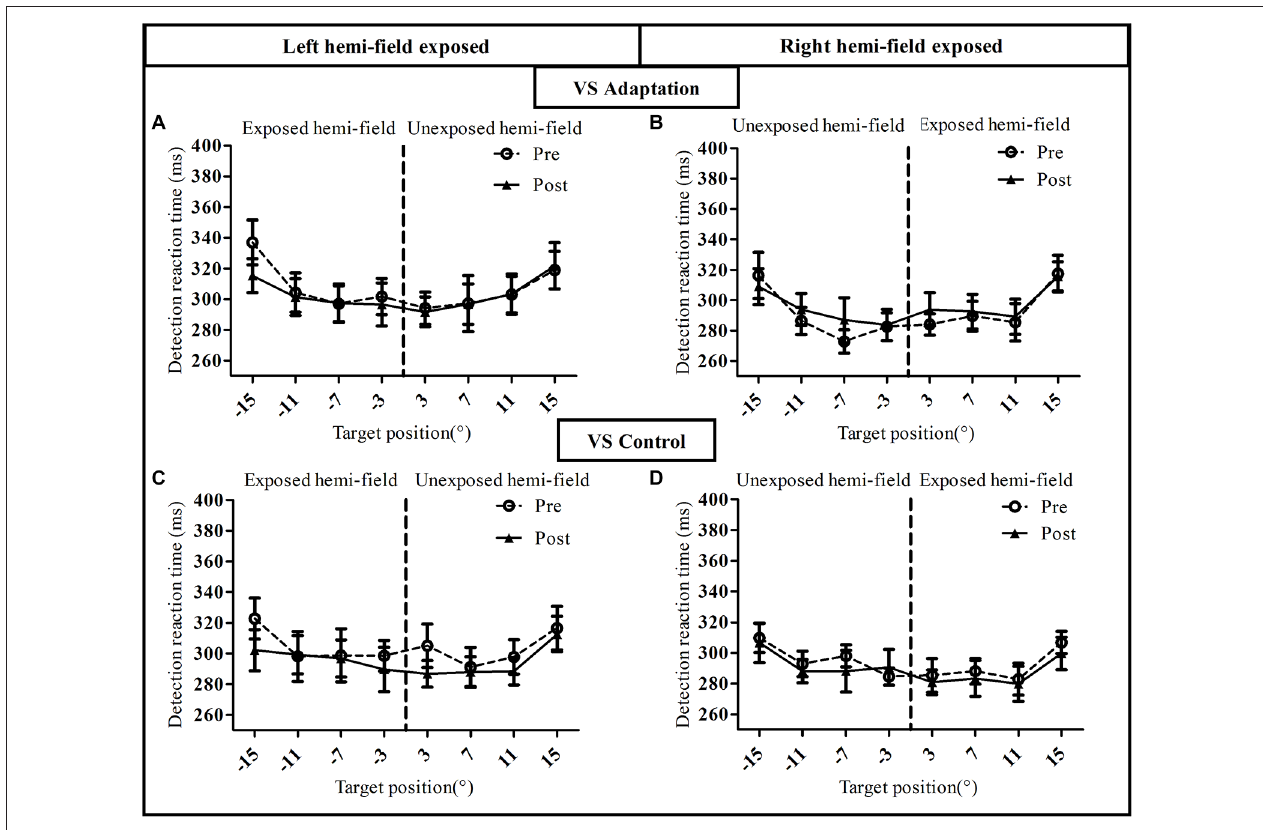
post-exposure phase (filled triangles, solid line). Upper row: adaptation groups ( A : Adapt-Left group, B : Adapt-Right group), lower row: control groups ( C : Control-left group, D : Control-right